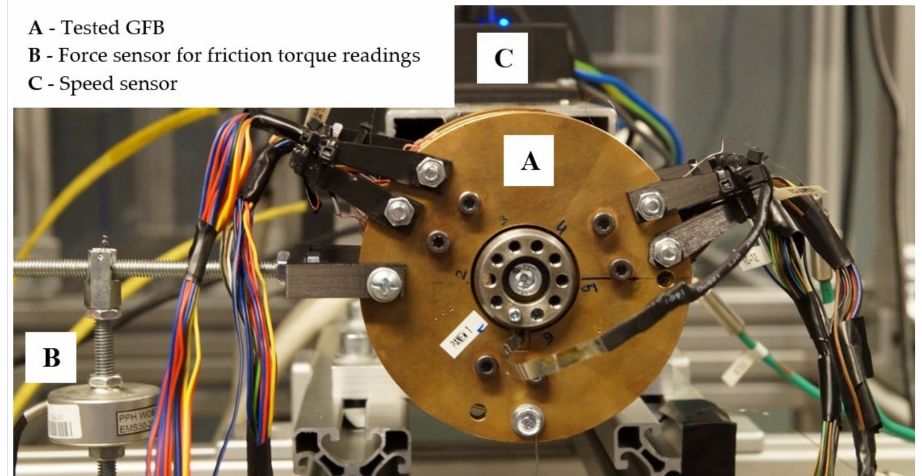
Figure 6. Complete GFB prototype assembly mounted on the electrospindle’s shaft. A simple 125 mm- long lever structure allowed for indirect friction torque measurement via a force sensor. Dedicated 3D-printed clamps, seen at both sides of the bearing, held the sensor cables. The fully assembled and equipped bearing weighed 1165 g. Apart from the gravitational force generated by the bearing itself, no additional load was considered in the test. Hence, the total load for the GFB was estimated to equal 11.43 N, considering the gravitational acceleration 9.81 m/s 2 . The digits handwritten on the bearing close to the shaft approximate the circumferential locations for the temperature